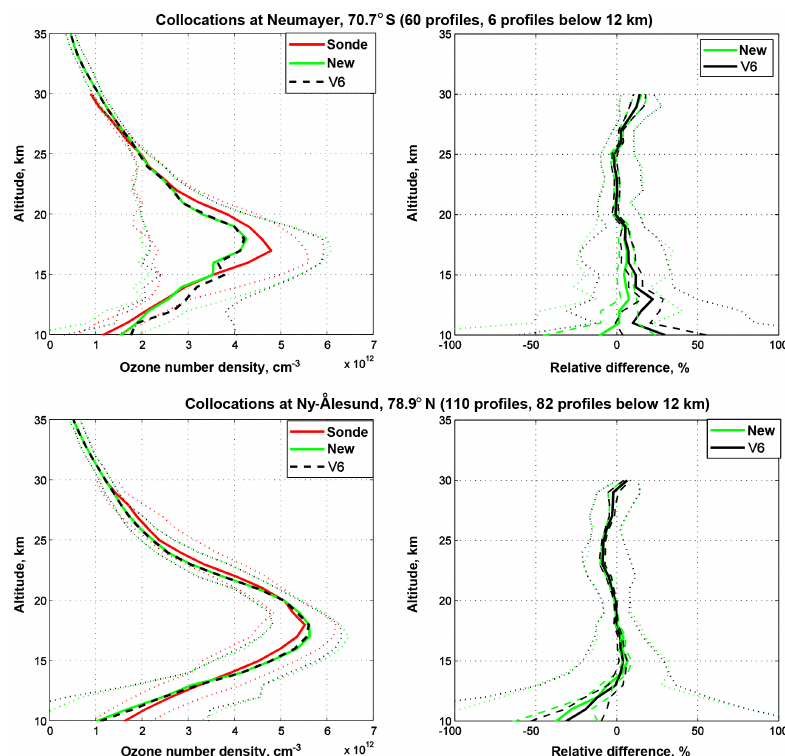
Figure 10. As Fig. 9 but for collocations at Neumayer (top) and Ny-Ålesund (bottom).